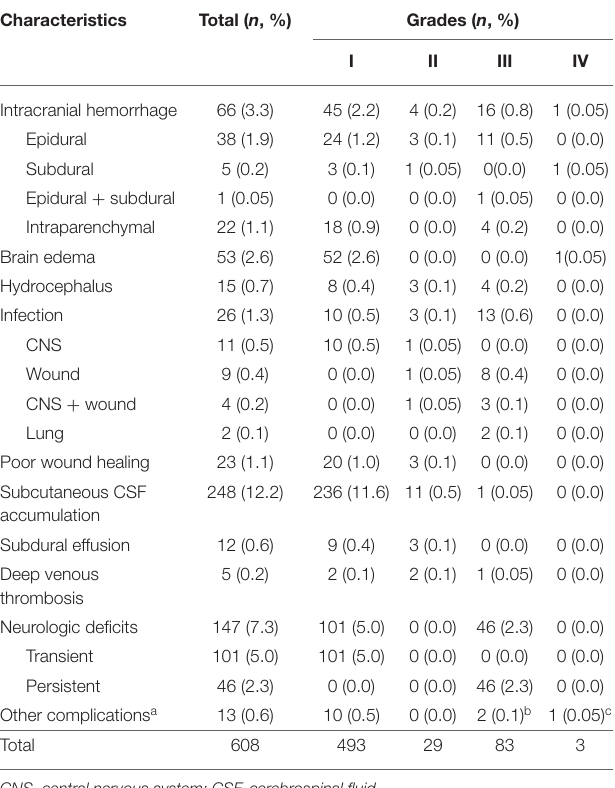
TABLE 1 | Incidences and grades of complications after epilepsy surgery (608 complications in 485 procedures). Characteristics